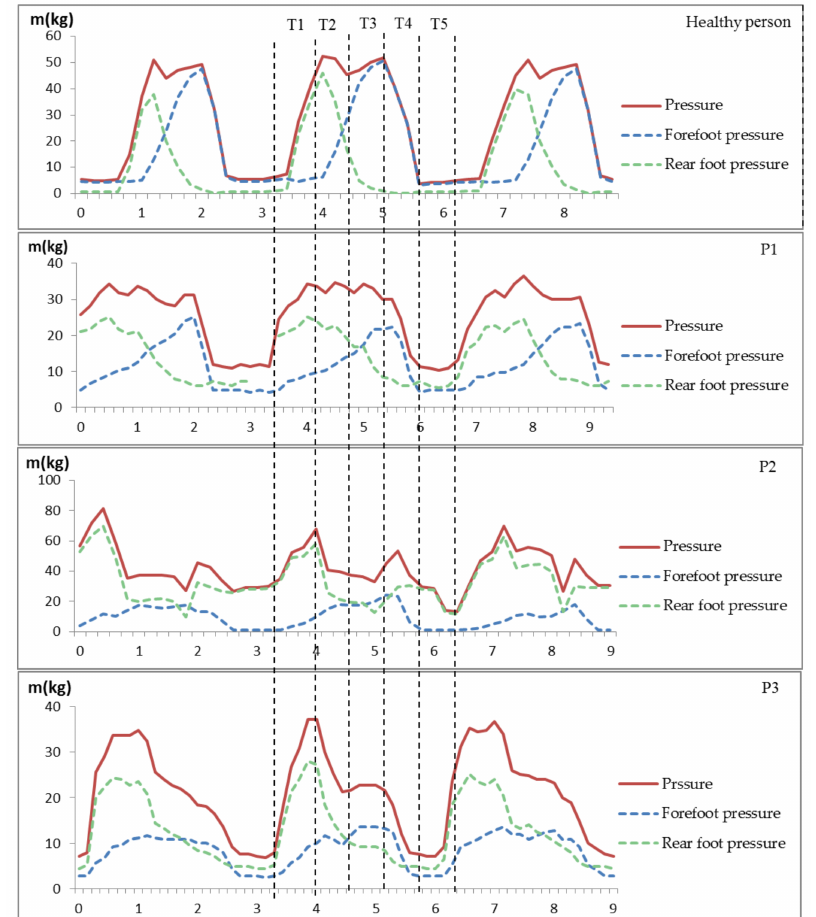
Figure 12. The comparison of normal gait and patients’